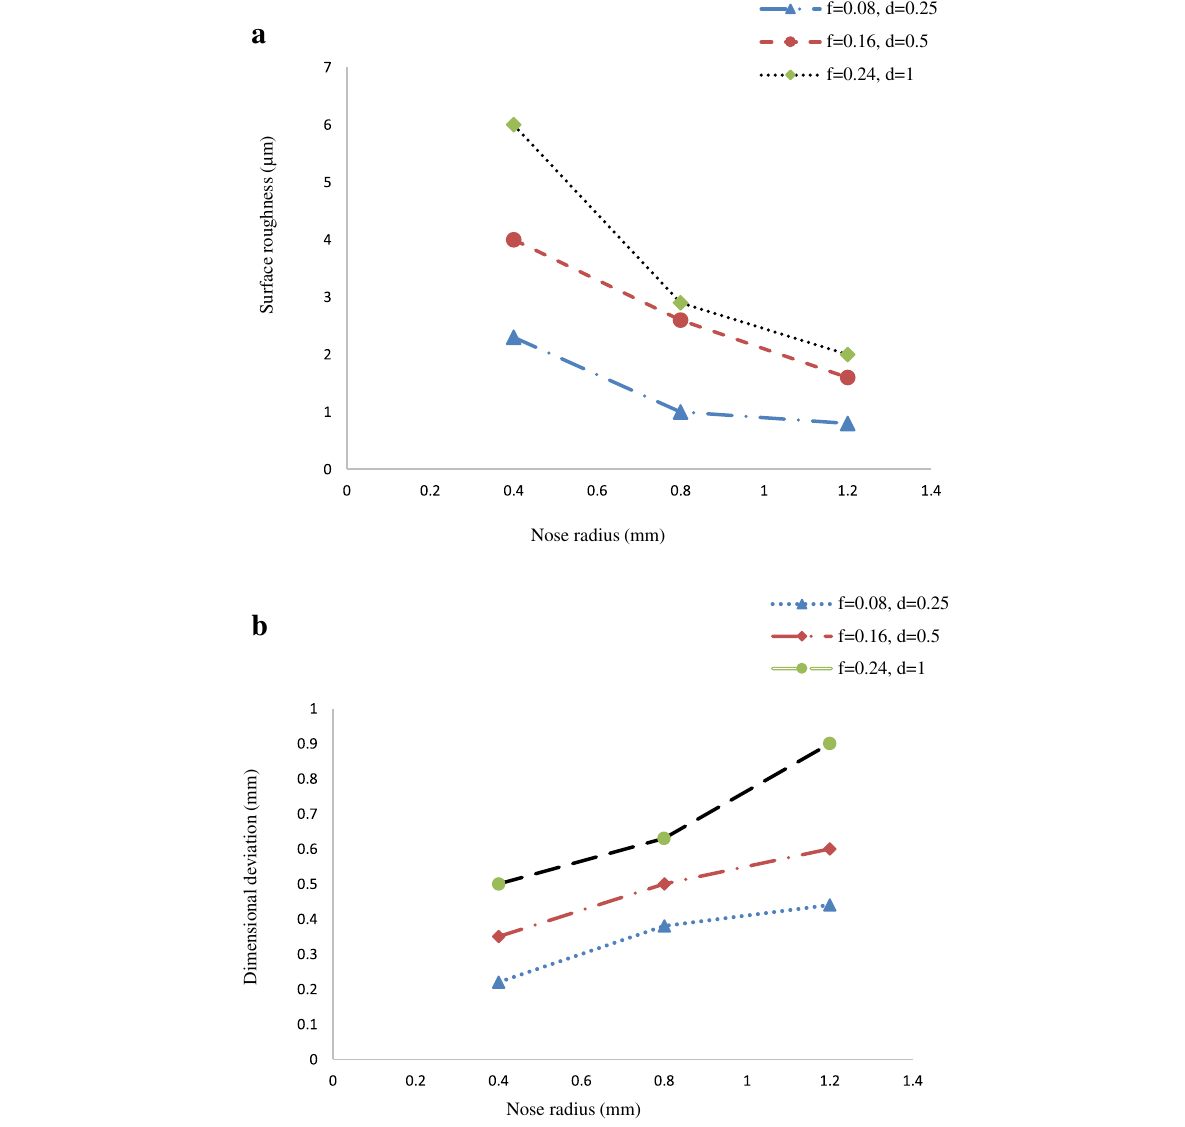
Fig. 1 a The insert nose radius effect on the surface roughness. b The effect of the insert nose radius on the dimensional deviation under different cutting